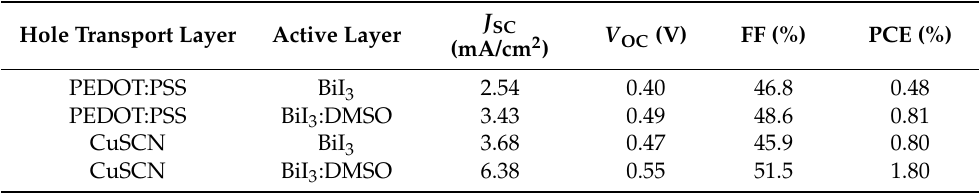
Figure 4. ( a ) p–i–n-structured planar heterojunction solar cells with CuSCN or PEDOT:PSS as HTL and BiI 3 or DMSO-coordinated BiI 3 as photoactive layer. ( b ) The energy level diagram of the p–i–n- structured devices. ( c ) J − V curves and ( d ) EQE spectrum of the corresponding solar cells. Table 1. Photovoltaic parameters of solar cells with CuSCN or PEDOT:PSS as HTL and BiI 3 or DMSO-coordinated BiI 3 as photoactive